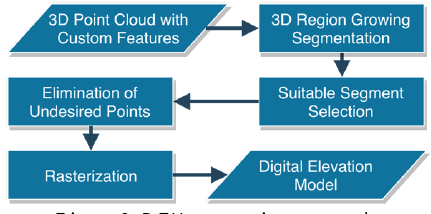
Figure 9. DEM extraction approach.